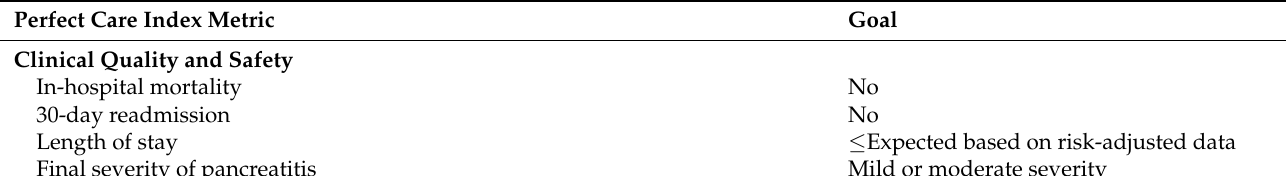
Table 1. Perfect care index metrics and